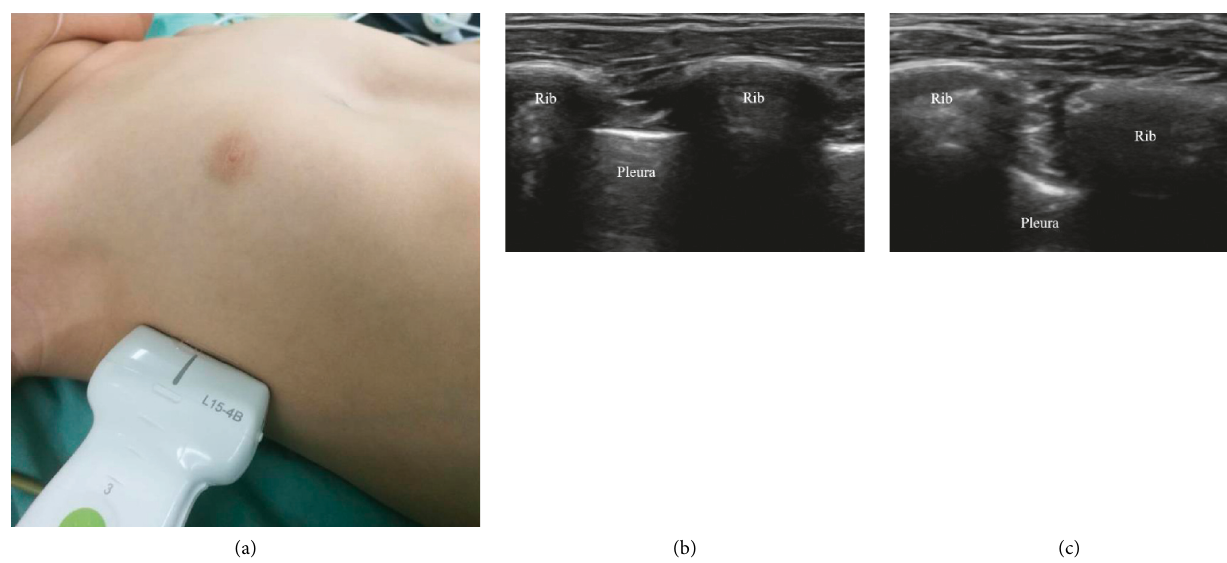
Figure 2: Ultrasound image of intercostal nerve blocks. (a) Placement of the ultrasound-probe for the performance of intercostal nerve block. (b) The hyperechoic ribs and the pleura. (c) After the administration of the local anesthetic, the bolus increased, and expansion of the potential space is